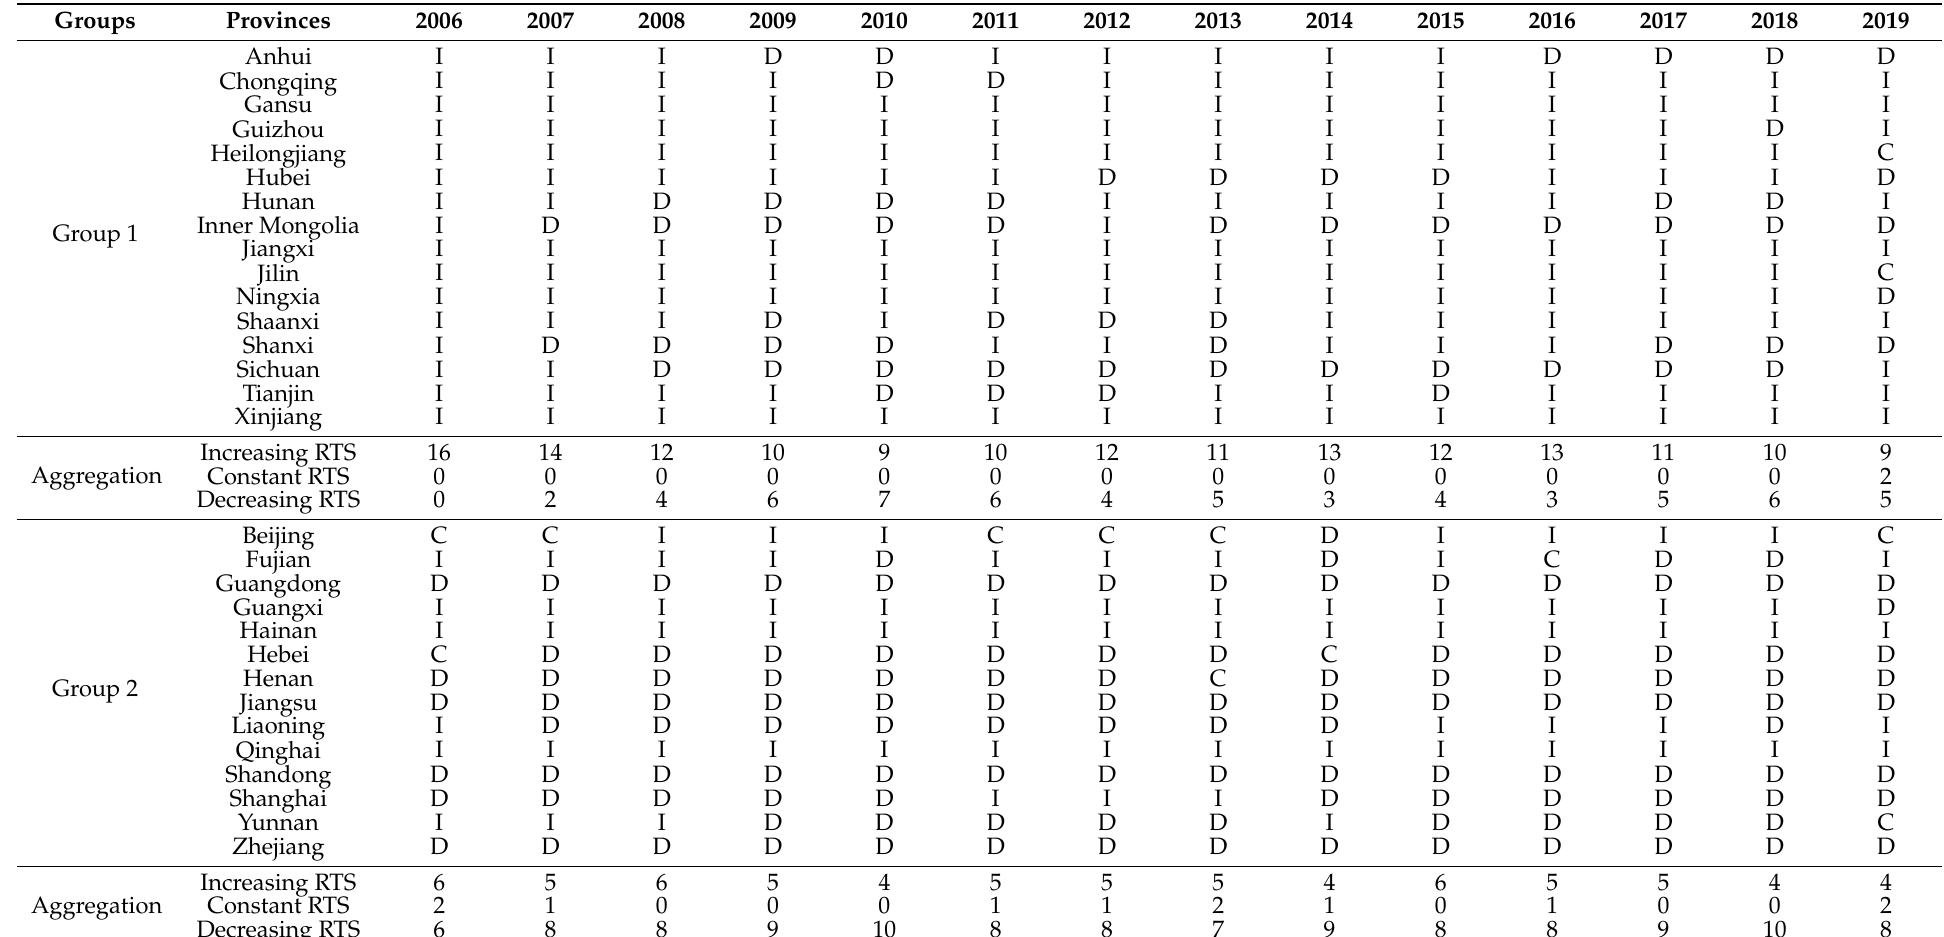
Table 8. Returns to Scale: type